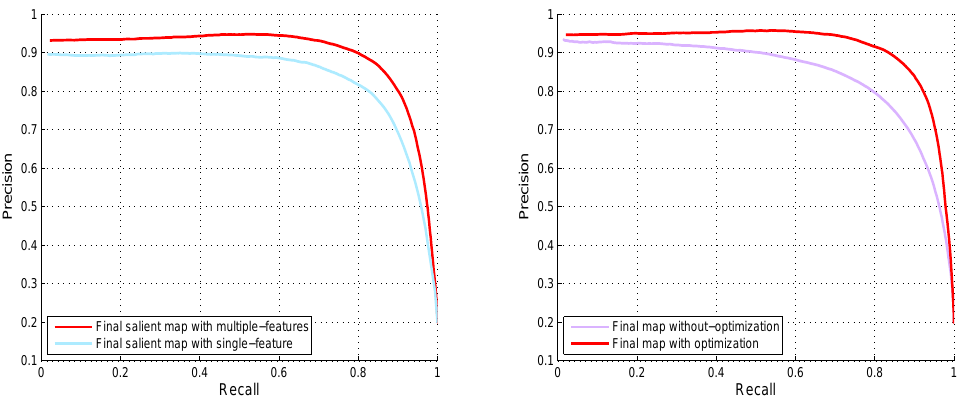
Figure 9. Graphical performance comparison of different stages of our method using PR-curves to validate the single feature, multi-featured, and enhanced results using the MSRA dataset.